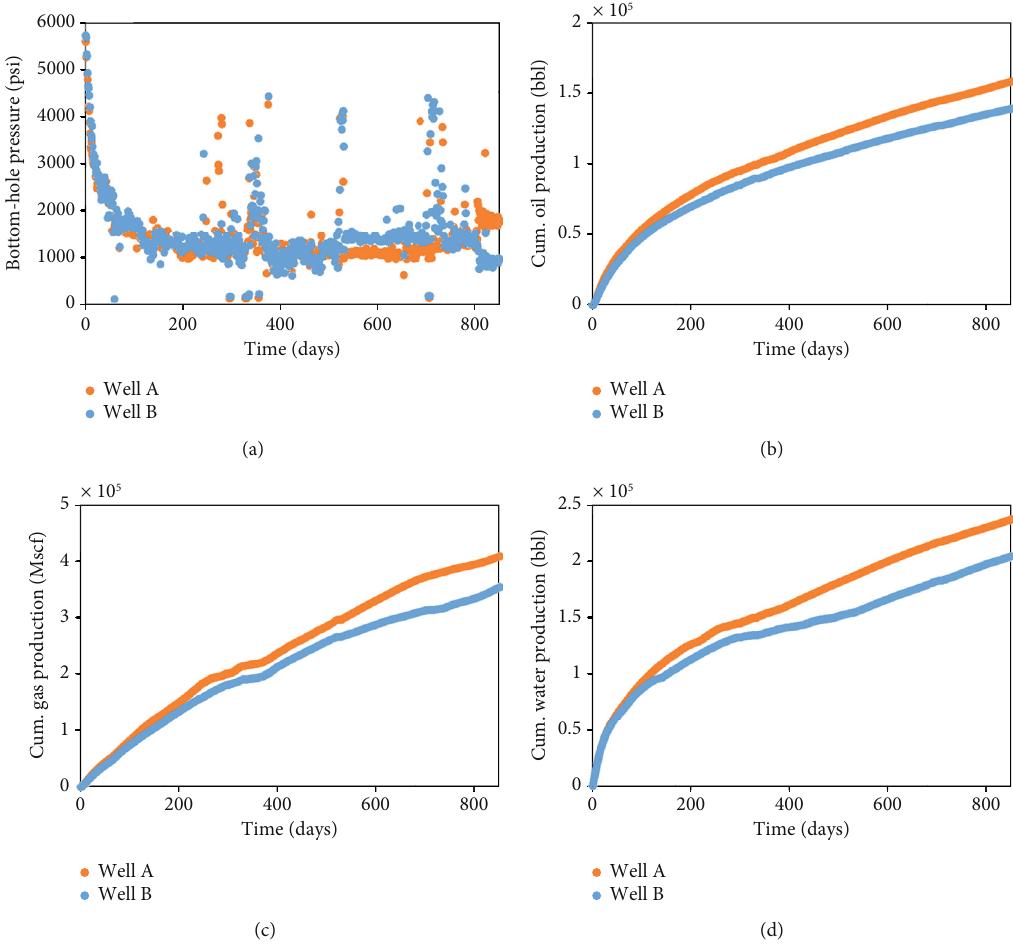
Figure 2: Production data comparison: (a) bottom-hole pressure, (b) cumulative oil production, (c) cumulative gas production, and (d) cumulative water production.